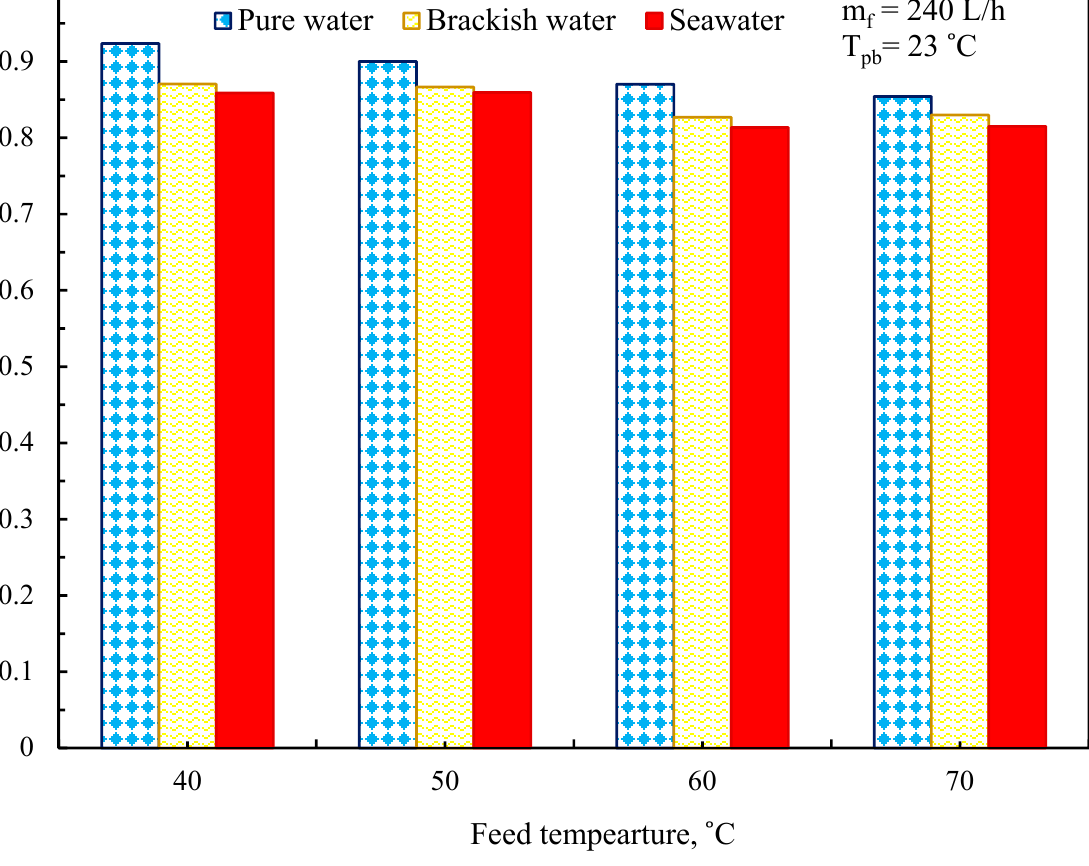
Figure 13. Influence of feed temperature on the temperature polarization factor.